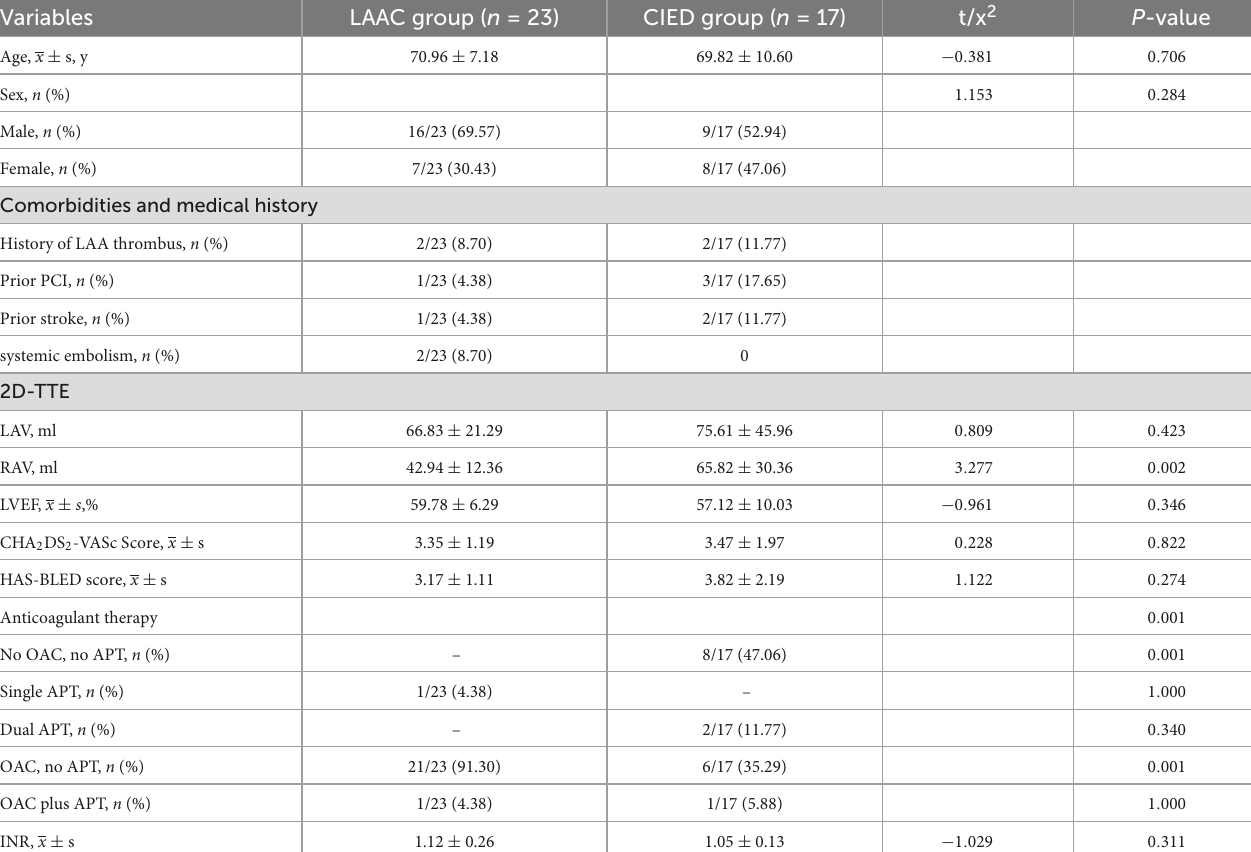
TABLE 1 Clinical characteristics of the patients with implant-related